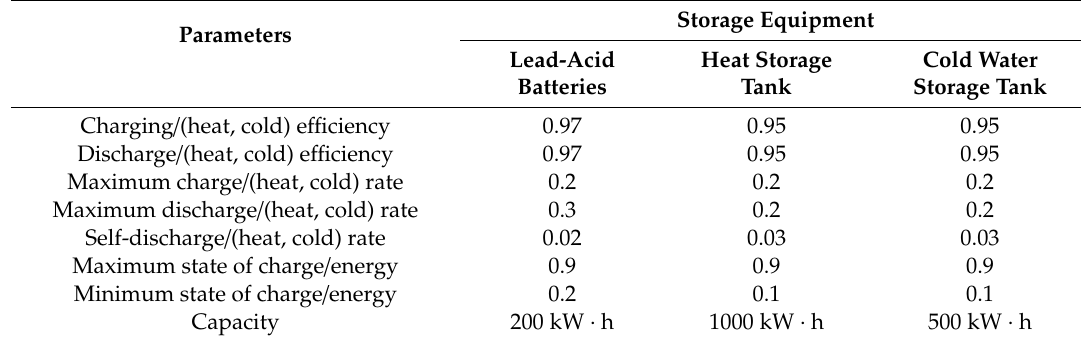
Table 2. The parameters of energy storage